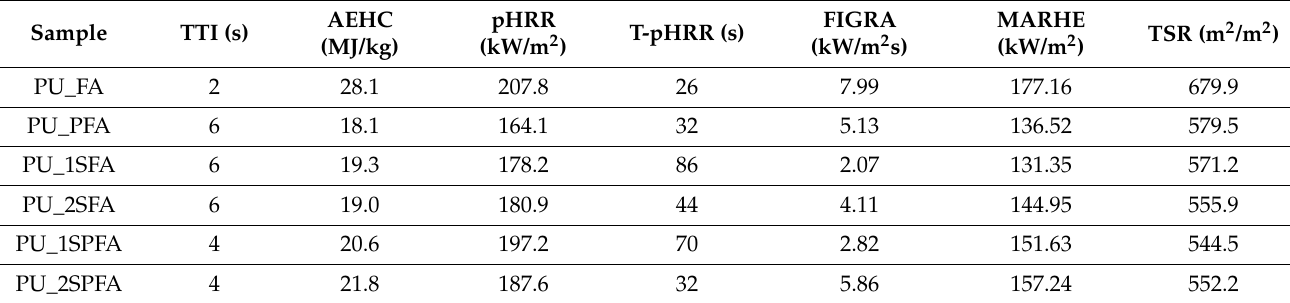
Table 6. Cone calorimeter results of polyurethane composites.